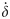
Standard deviation of steer rate (δ˙) versus speed.Cyclists exhibit less variation of steer rate (F = 15.121, p < 0.001) than non-cyclists. All subject data are shown; connected points indicate data from the same subject.